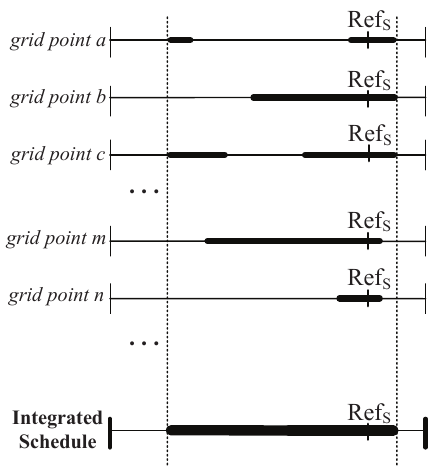
Figure 2. The duty cycle of sensor S is integrated from the scheduling of all GPs located within the sensing range of sensor S